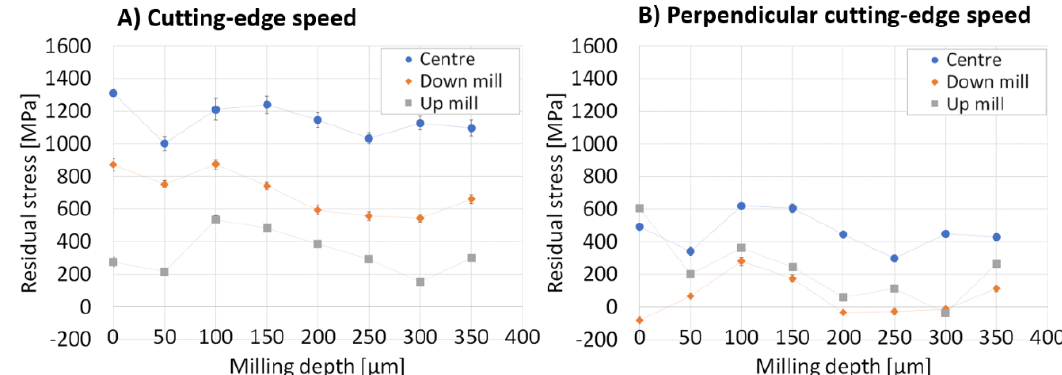
Figure 6. Surface residual stresses at up-, centre and down-milled part of the slot. The error bars represent the errors from linear curve fitting of diffraction data.